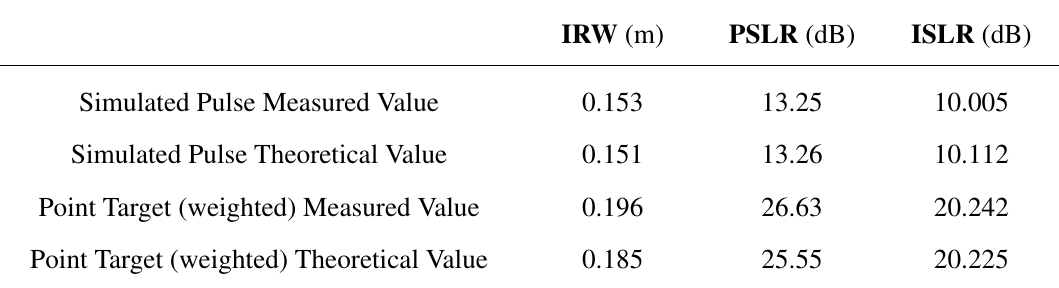
Table 2. Range impulse response of simulated pulse and real point